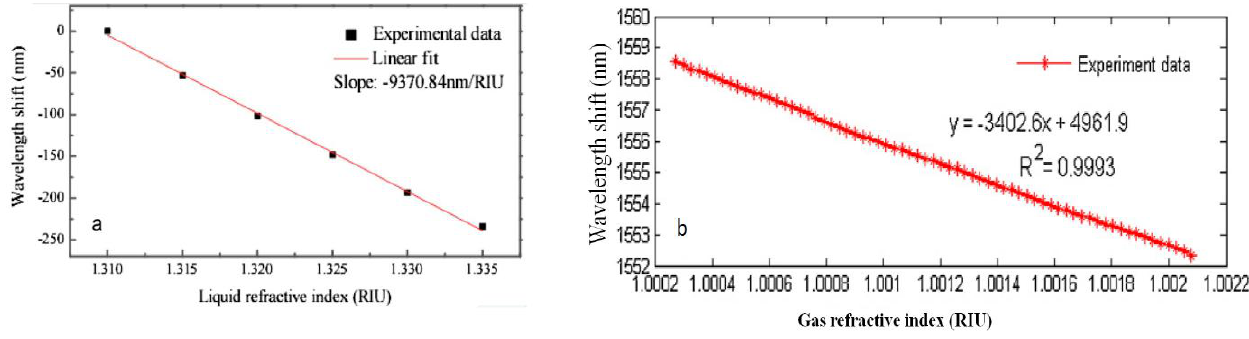
Figure 12. The RI sensitivity of the open cavity in-line MZI fabricated by different methods: ( a ) using femtosecond laser, as shown in Figure 9(d); ( b ) splicing with a large intentional lateral offset, as shown in Figure